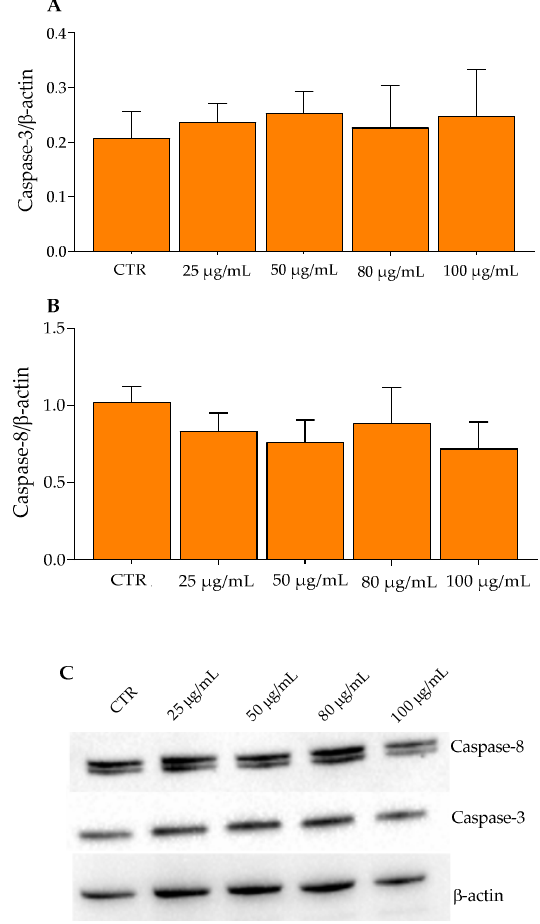
Figure 4. Western blotting analysis of Caspase proteins in HT29 cells exposed to Aglianico GP gastrointestinal digested extract at increasing concentrations for 24 h. ( A ) Caspase-3 proteins; ( B ) Caspase-8 proteins; ( C ) Relative blots. All data represent the results of three different experiments (means ± SD).